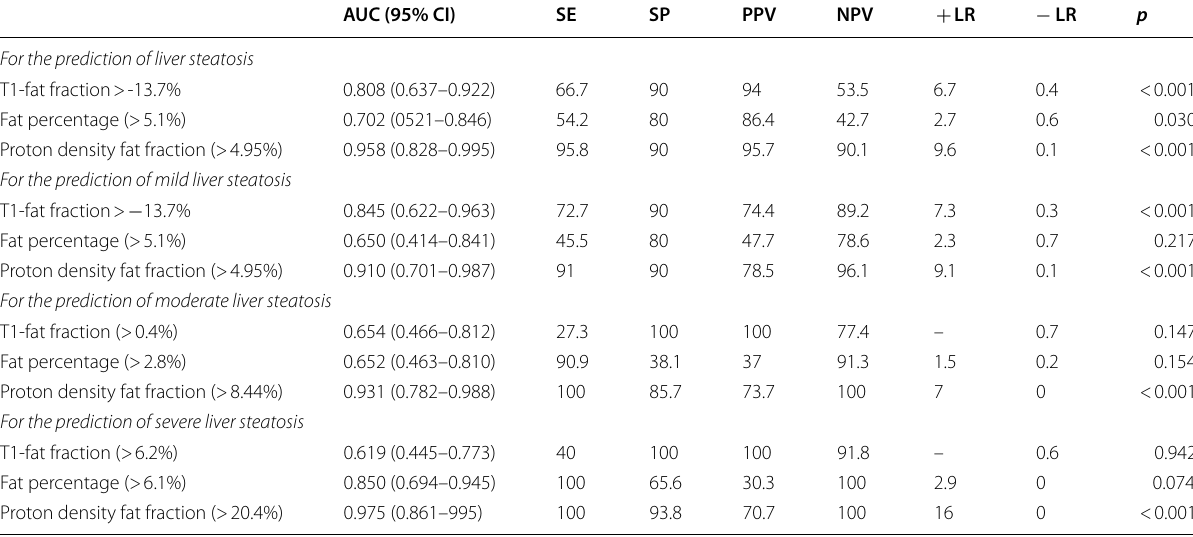
Table 2 Diagnostic accuracy of magnetic resonance imaging (MRI) parameters to predict hepatic steatosis with the best predictive